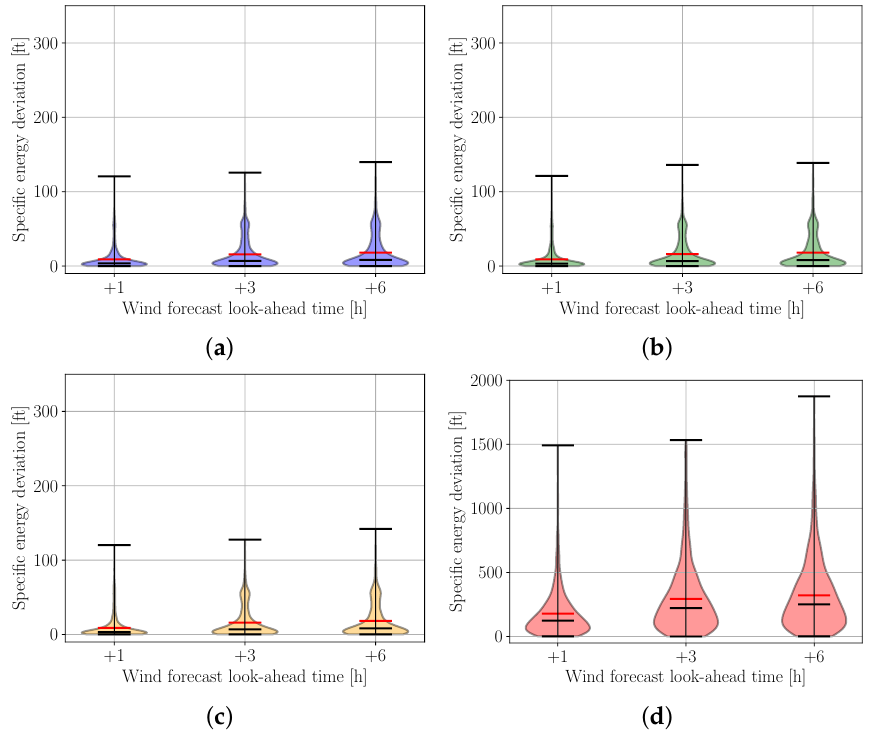
Figure 6. Specific energy deviation at the metering/merging fix. ( a ) NMPC. ( b ) SbNMPC. ( c ) AsN- MPC. ( d )